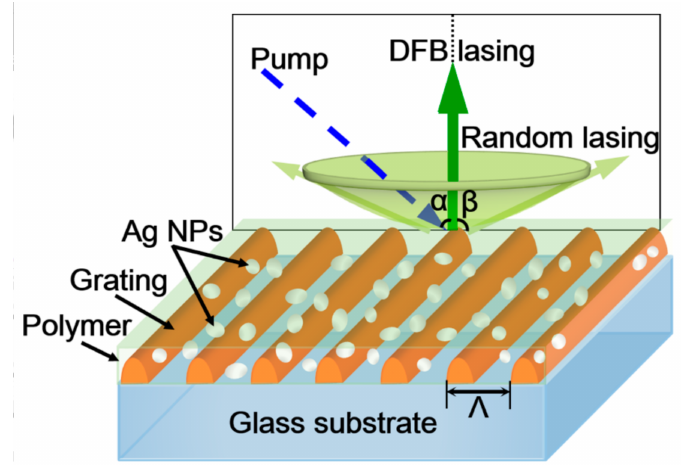
Figure 1. Schematic of a polymer laser based on the periodic-random compound cavity. The blue/green arrow denotes the direction of the pump/DFB lasing. The light-green cone indicates the output direction of the random laser. α , β are the incident angle of the pump and the solid angle of the random laser output, respectively. α = 20 ◦ . Λ is the period of the